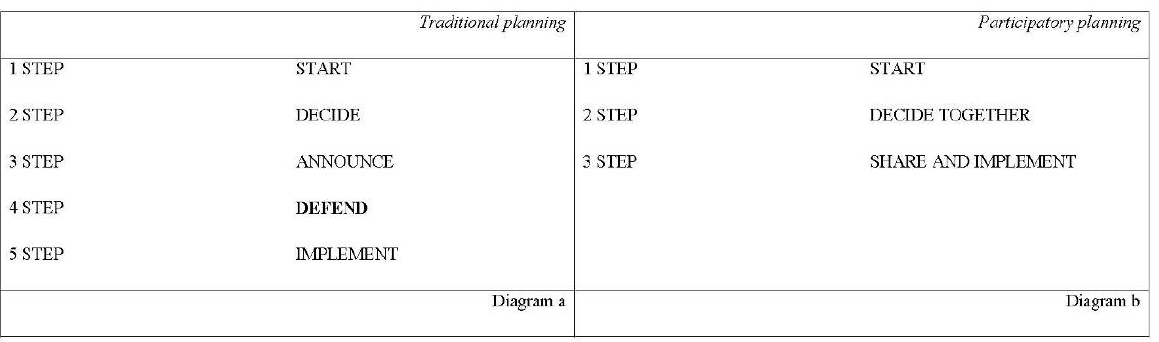
Figure 1. Moving from a traditional decision-making process to a participatory